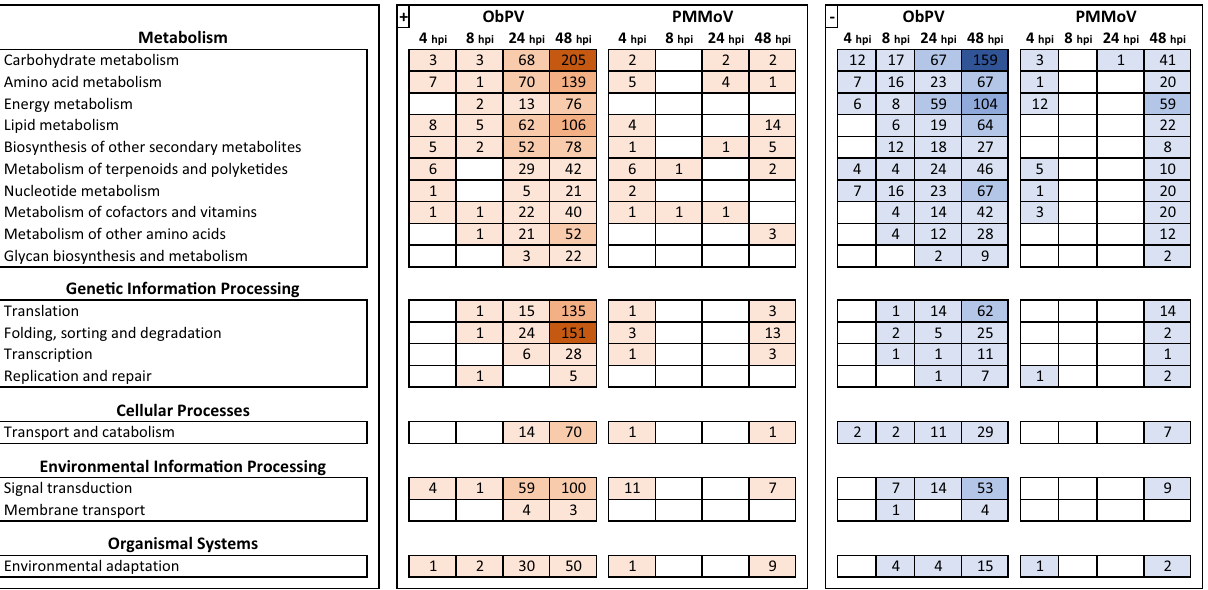
Figure 4. KEGG annotation of differentially expressed genes (DEGs) in pepper leaves inoculated with Obuda pepper virus (ObPV) and Pepper mild mottle virus (PMMoV) at 4, 8, 24 and 48 h post-inoculation (hpi). Color codes: brown: up-regulated genes; blue: down-regulated genes; empty cells: no genes with significantly changed expression. The KEGG pathway database 43 was used with the permission of Kanehisa Laboratories,